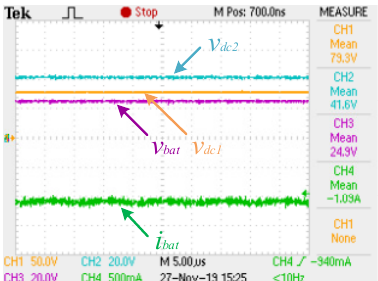
Figure 9. B2G operation mode: voltage on the primary dc-link (CH1: 20 V/div), voltage on the secondary dc-link (CH2: 10 V/div), voltage on the batteries (CH3: 10 V/div), current at the BESS (CH4: 500 mA/div).